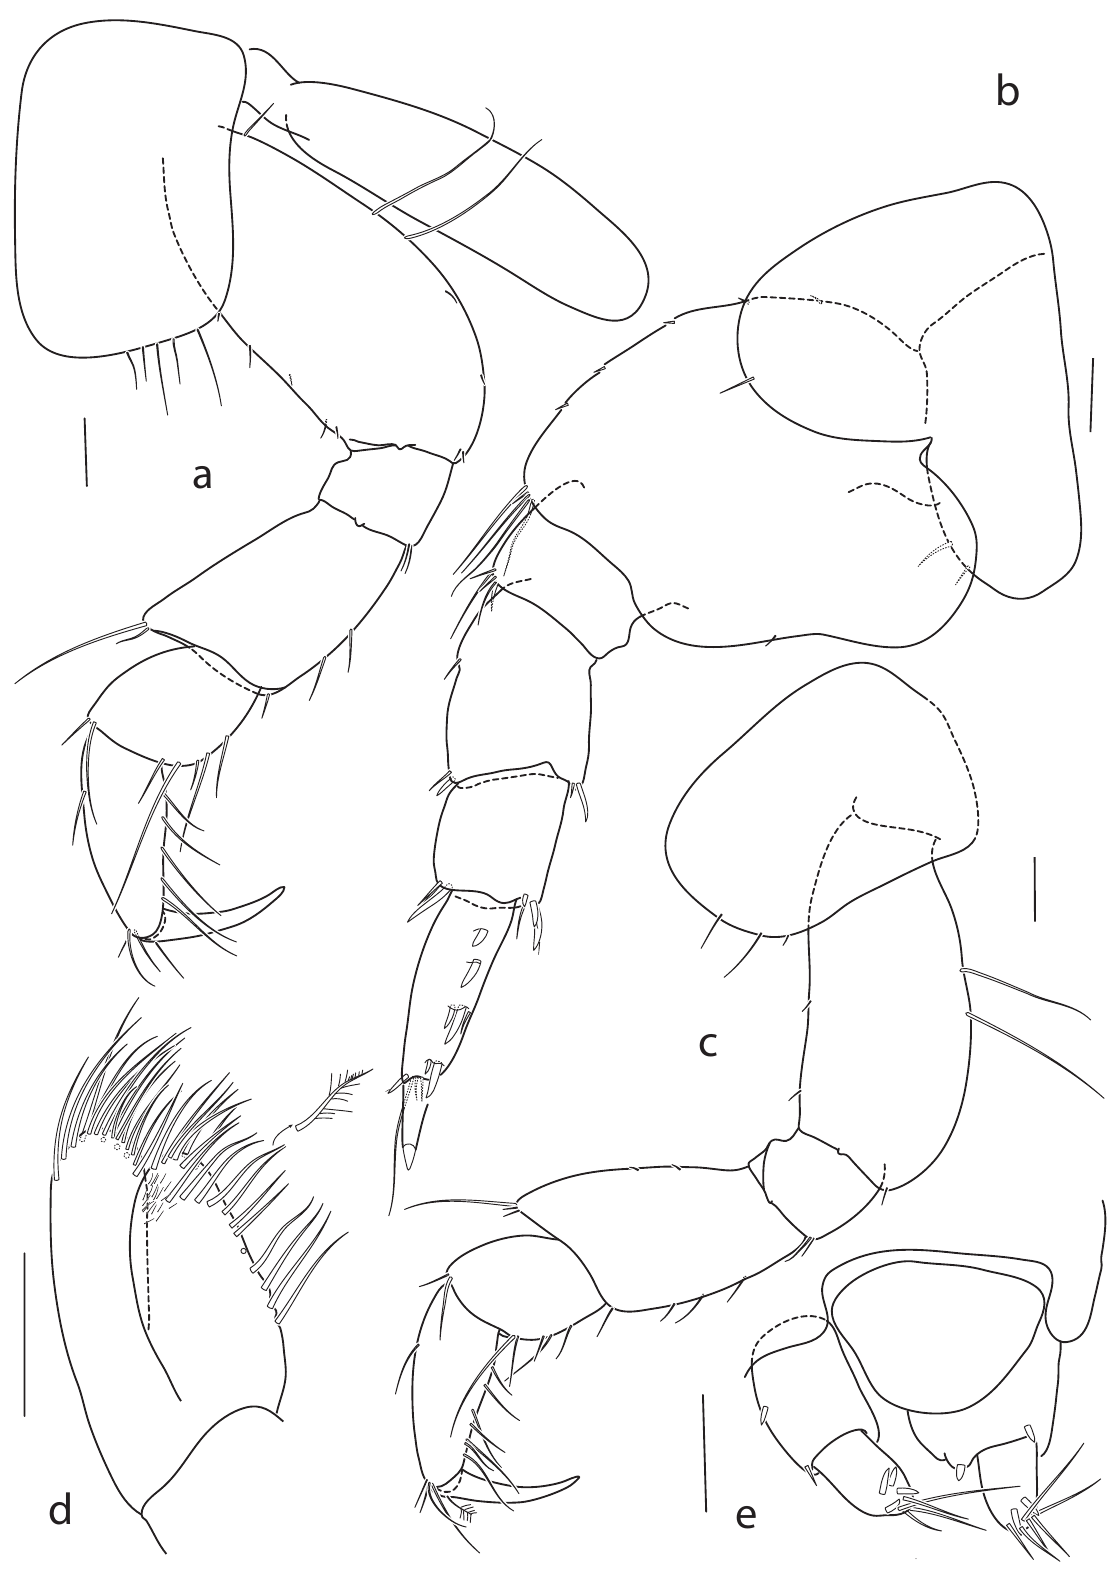
Fig. 10. Haplocheira barbimana robusta K.H. Barnard, 1932, ♂, 4.2 mm (ZMB 34098). a . Pereopod 3. b . Pereopod 5. c . Pereopod 4. d . Maxilla 2. e . Telson and uropod 3. Scale bars = 100